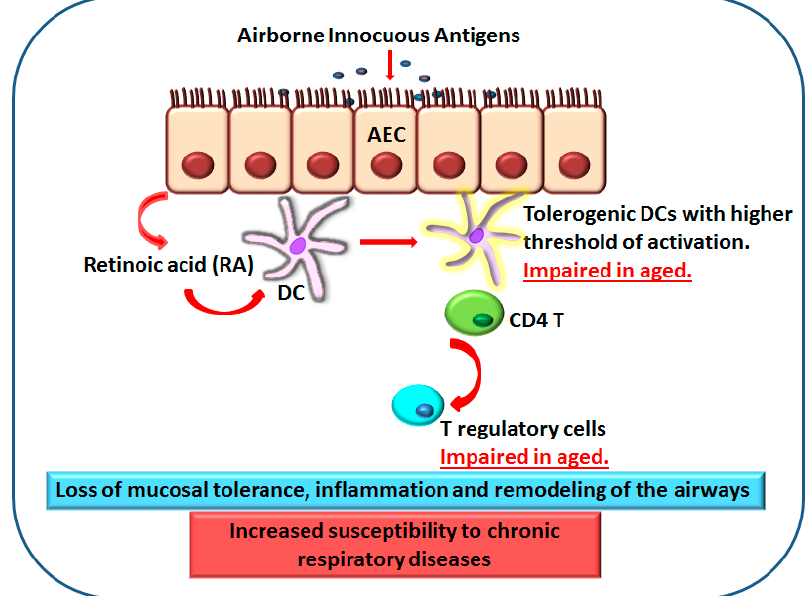
Figure 2. Impaired response of DCs from elderly to retinoic acid (RA) results in a loss of mucosal tolerance and inflammation. Retinoic acid produced by AECs (arrow 1, top) acts on DCs (arrow 2, middle) to induce T regulatory cells (arrow 3, bottom) and mucosal tolerance to prevent immune response to harmless inhaled antigens. DCs from aged subjects display reduced response to RA which leads to impaired induction of T regulatory cells and mucosal tolerance. This enhances inflammation and leads to airway hyper-responsiveness.